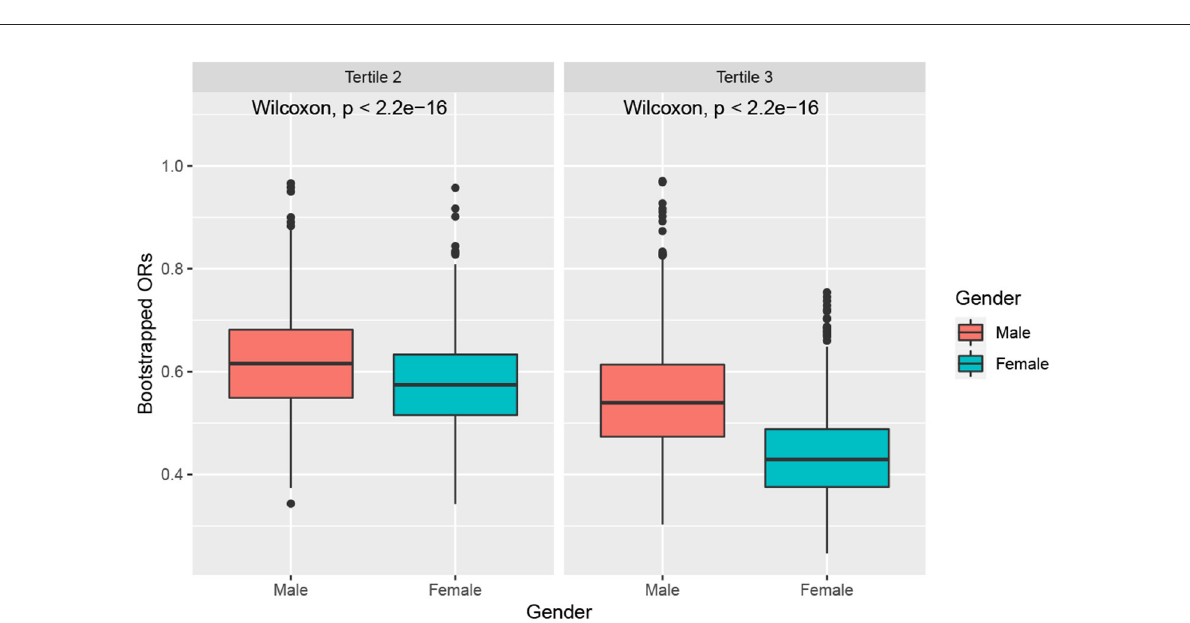
FIGURE2 Boxplot of bootstraped ORs by gender. The model was adjusted for age, race, educational level, marital status, annual family income, BMI, caffeine intake, total energy intake, hypertension, diabetes, smoking status, drinking status, sedentary activity, and total activity per